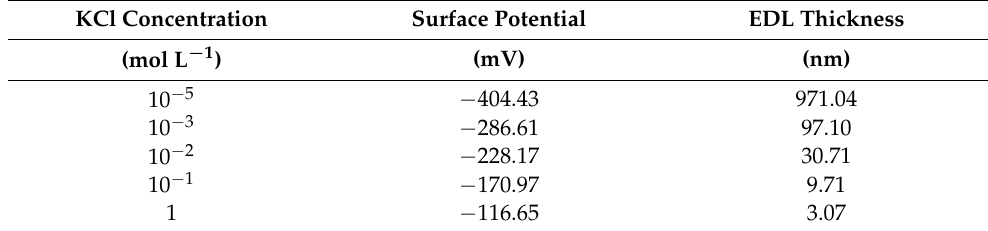
Table 1. Surface potential and EDL thickness of the soil under different KCl concentrations.